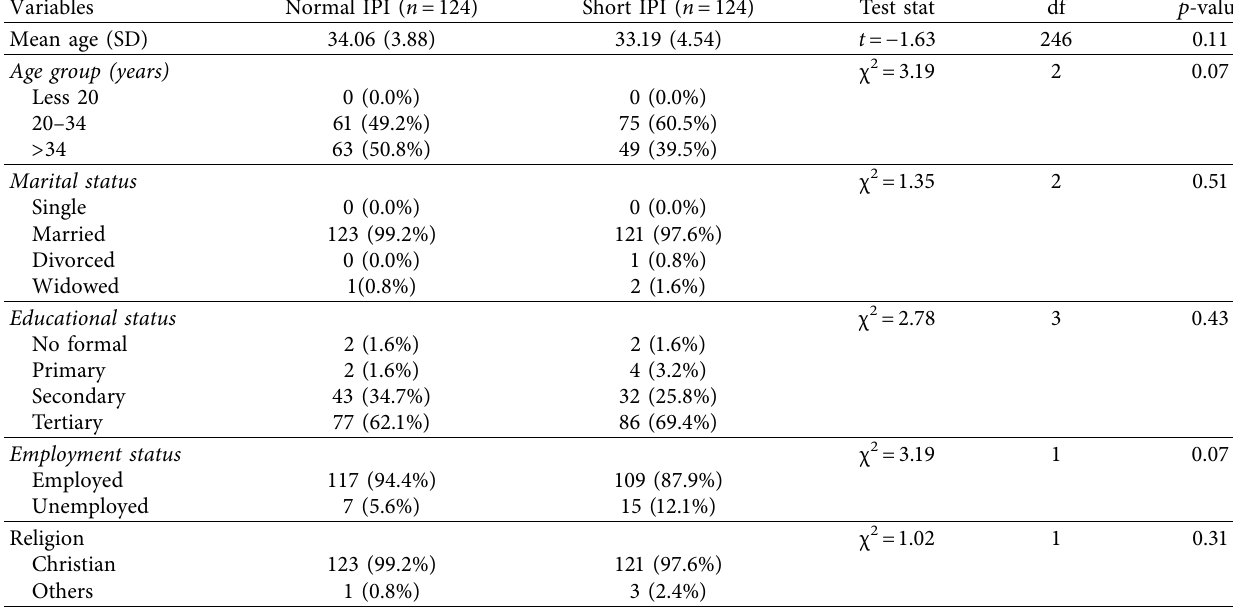
Table 1: Sociodemographic characteristics of the study